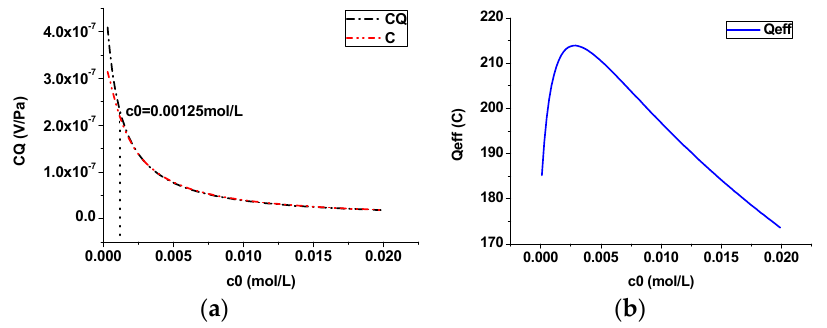
Figure 6. Effect of the salinity (steady condition, including the large-Debye-length case): ( a ) stream- ing potential coupling coefficient; ( b ) effective net residual charge density. potential coupling coefficient; ( b ) effective net residual charge density.